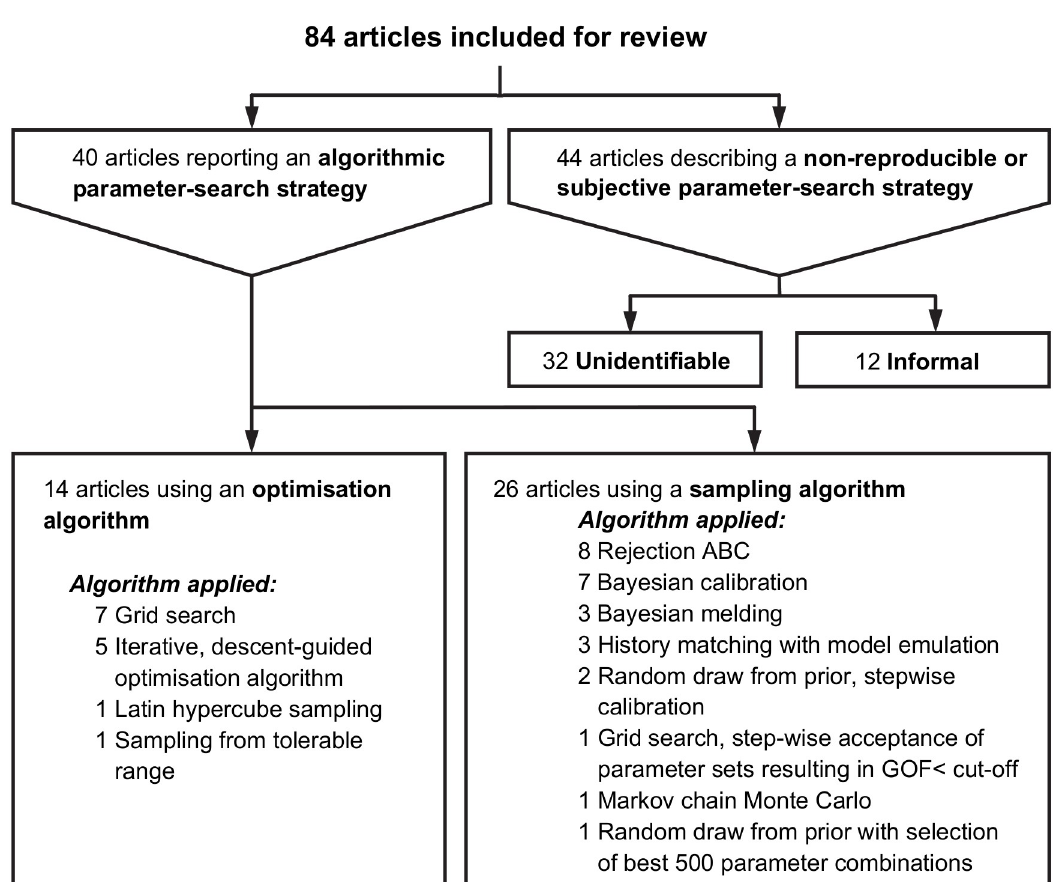
Fig 2. Reporting and application of parameter search strategies in epidemiological studies.